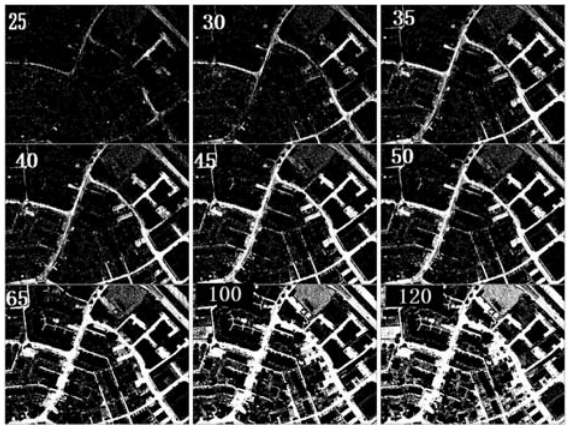
Figure 4. Comparison of different intensity For these areas with the shape are similar circle or square, we adopt the ratio of the circumference and area as judgment standard. For square, a and b are defined as side, S represents area and W represents circumference.